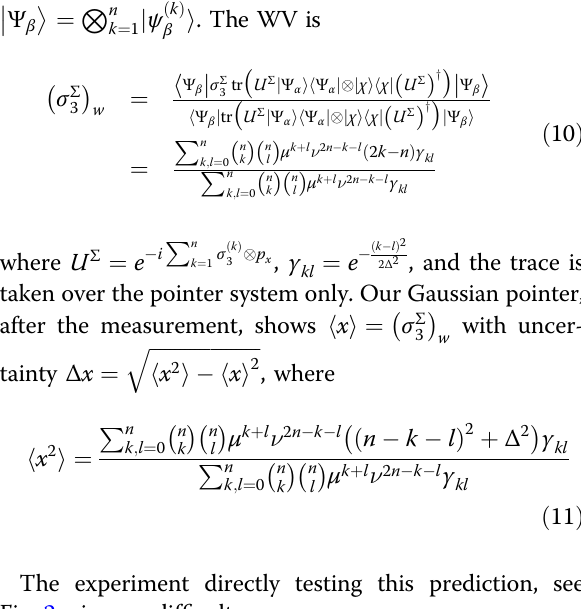
anomalous WV in terms of relative uncertainty. Note that the fi nal width of the pointer is smaller than the initial width, due to a subtle narrowing effect 28 .